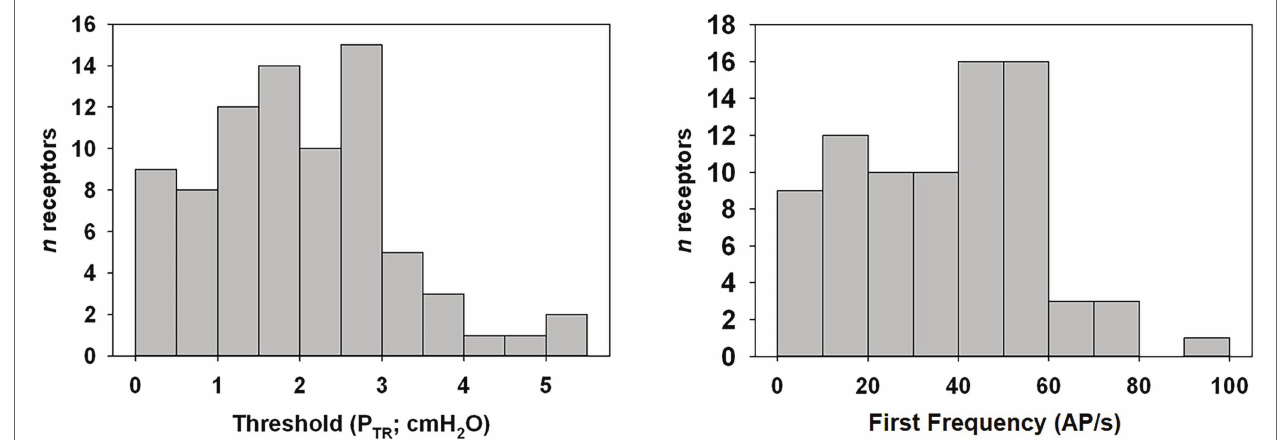
FIGURE 4 | Distribution histogram of P TR threshold of activation and first frequency of murine SARs. Tonic receptors, active at FRC or 0 cmH 2 O ( n = 5), were excluded from analysis. Note that the majority of SARs was active at relatively low